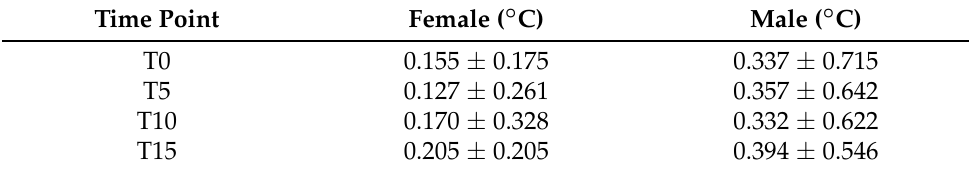
Table 7. Mean temperature difference at each time point for the female and male